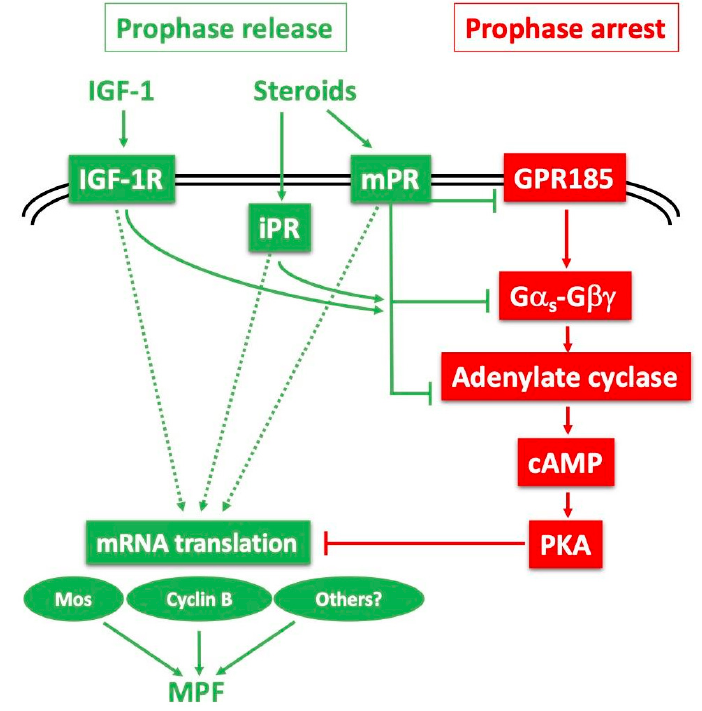
Figure 5. Models for release of the Xenopus oocyte prophase block: probable cooperation between several receptors and downstream pathways. The constitutively active G α s -coupled GPR185 maintains high cAMP and PKA activity, ensuring the prophase arrest (red pathway—right). The prophase release (green pathway—left) is triggered by steroids, mainly progesterone, with the potential contribution of IGF-1 and its receptor (IGF-1R). Progesterone could interact with its canonical nuclear receptor (iPR) but also a plasma membrane-bound receptor (mPR). Upon binding to progesterone, these receptors could inhibit the GPR185 pathway, and / or independently inhibit adenylate cyclase by recruiting G α i or inhibiting G α S . They could also launch positive downstream signalling independently of cAMP and PKA. These cascades converge to the synthesis of new proteins required for activating MPF.